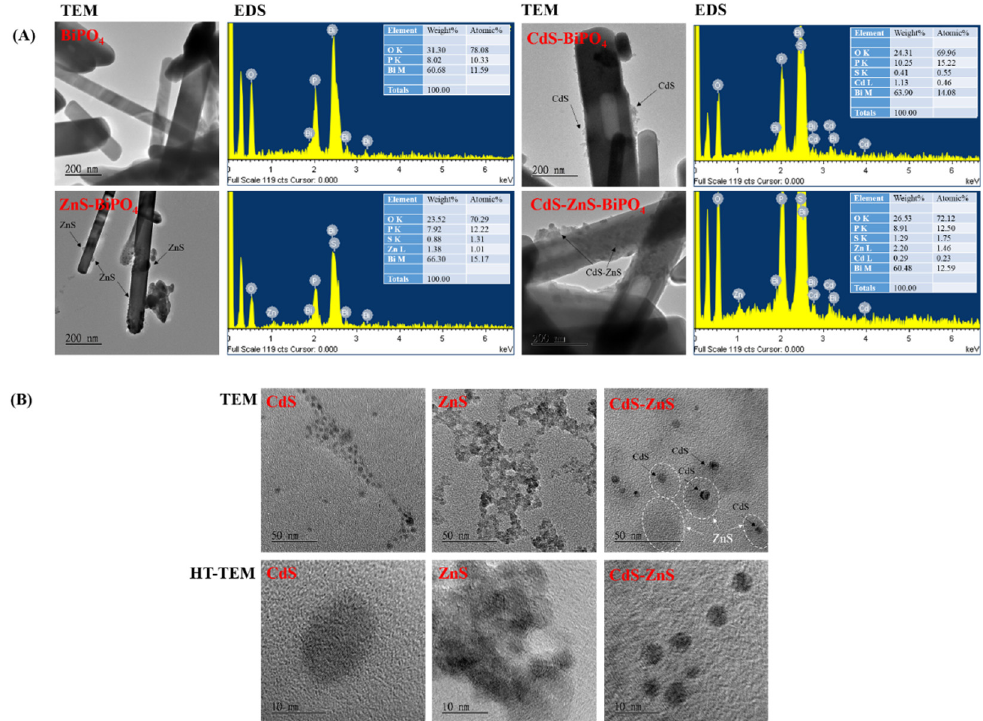
Figure 1. ( A ) TEM images and EDS spectra of BiPO 4 , CdS-BiPO 4 , ZnS-BiPO 4 , and CdS-ZnS-BiPO 4 (the precursor solution contained the molar ratio of Cd to Zn at 1:7) nanocomposites. ( B ) TEM and HR-TEM images of CdS, ZnS, and CdS-ZnS (the precursor solution contained the molar ratio of Cd to Zn at 1:7) nanoparticles.